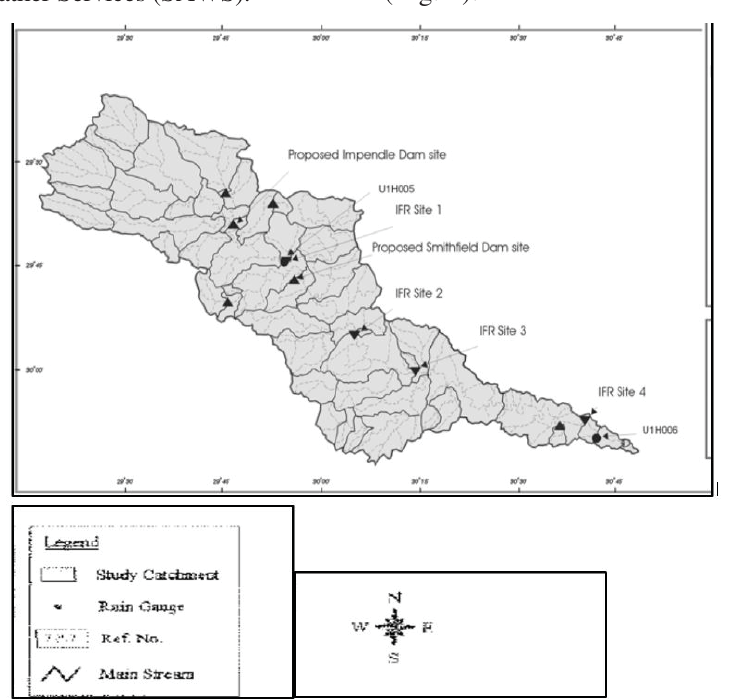
Fig. 4. The study